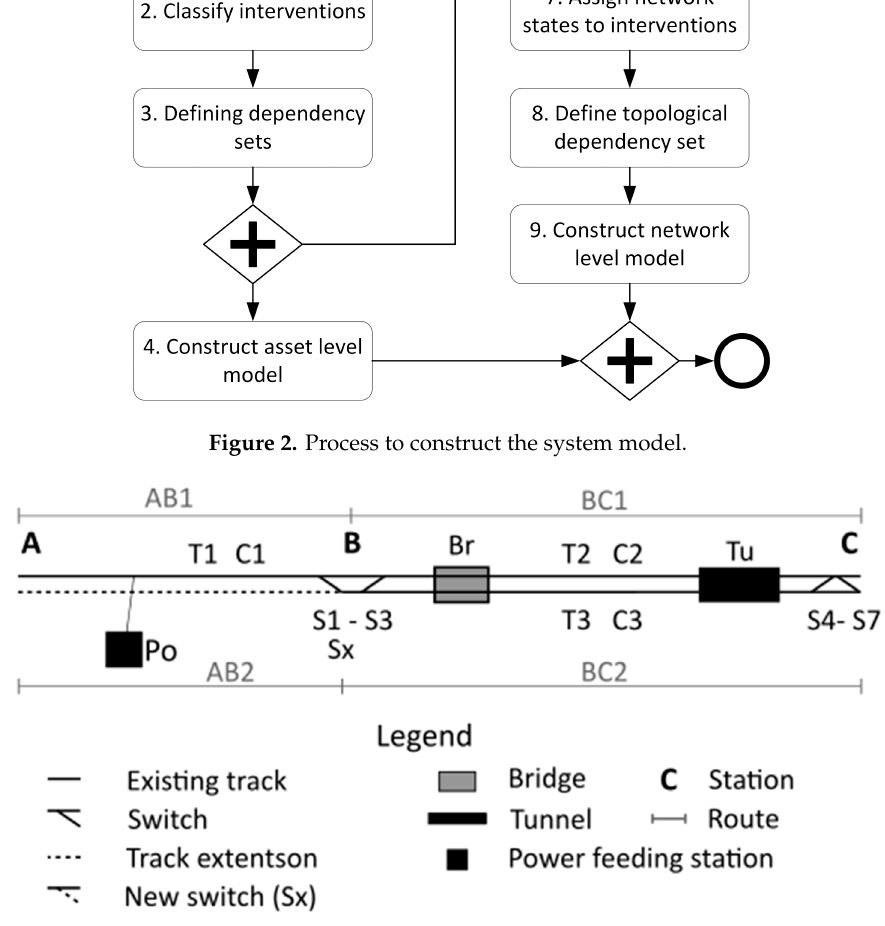
Figure 3. Example network. Table 1. Candidate